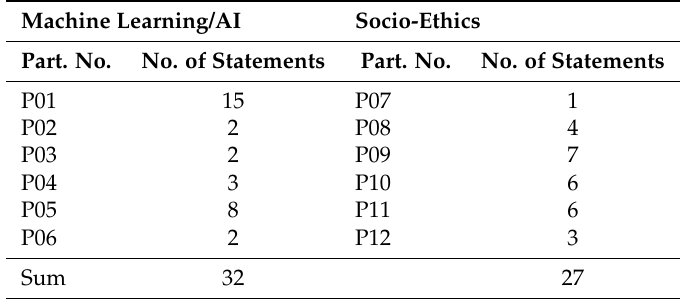
Table 3. Number of statements per interviewee related to learning from experience.